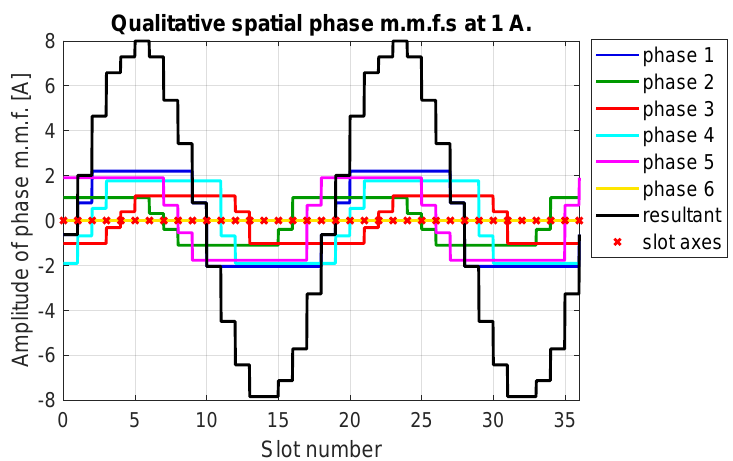
Figure 10. Spatial MMF distribution for a six-phase machine with N = 36, p = 2 and y = 2.